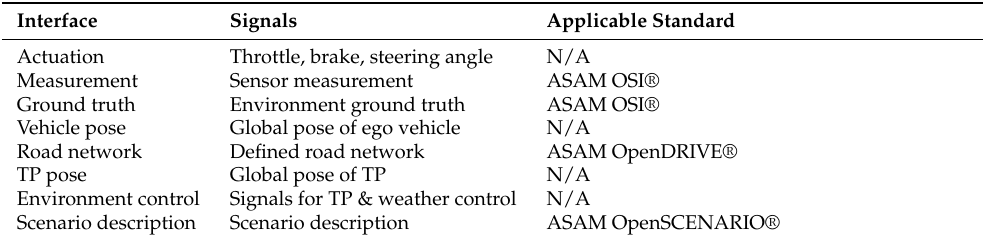
Table 2. Interfaces of the virtual validation